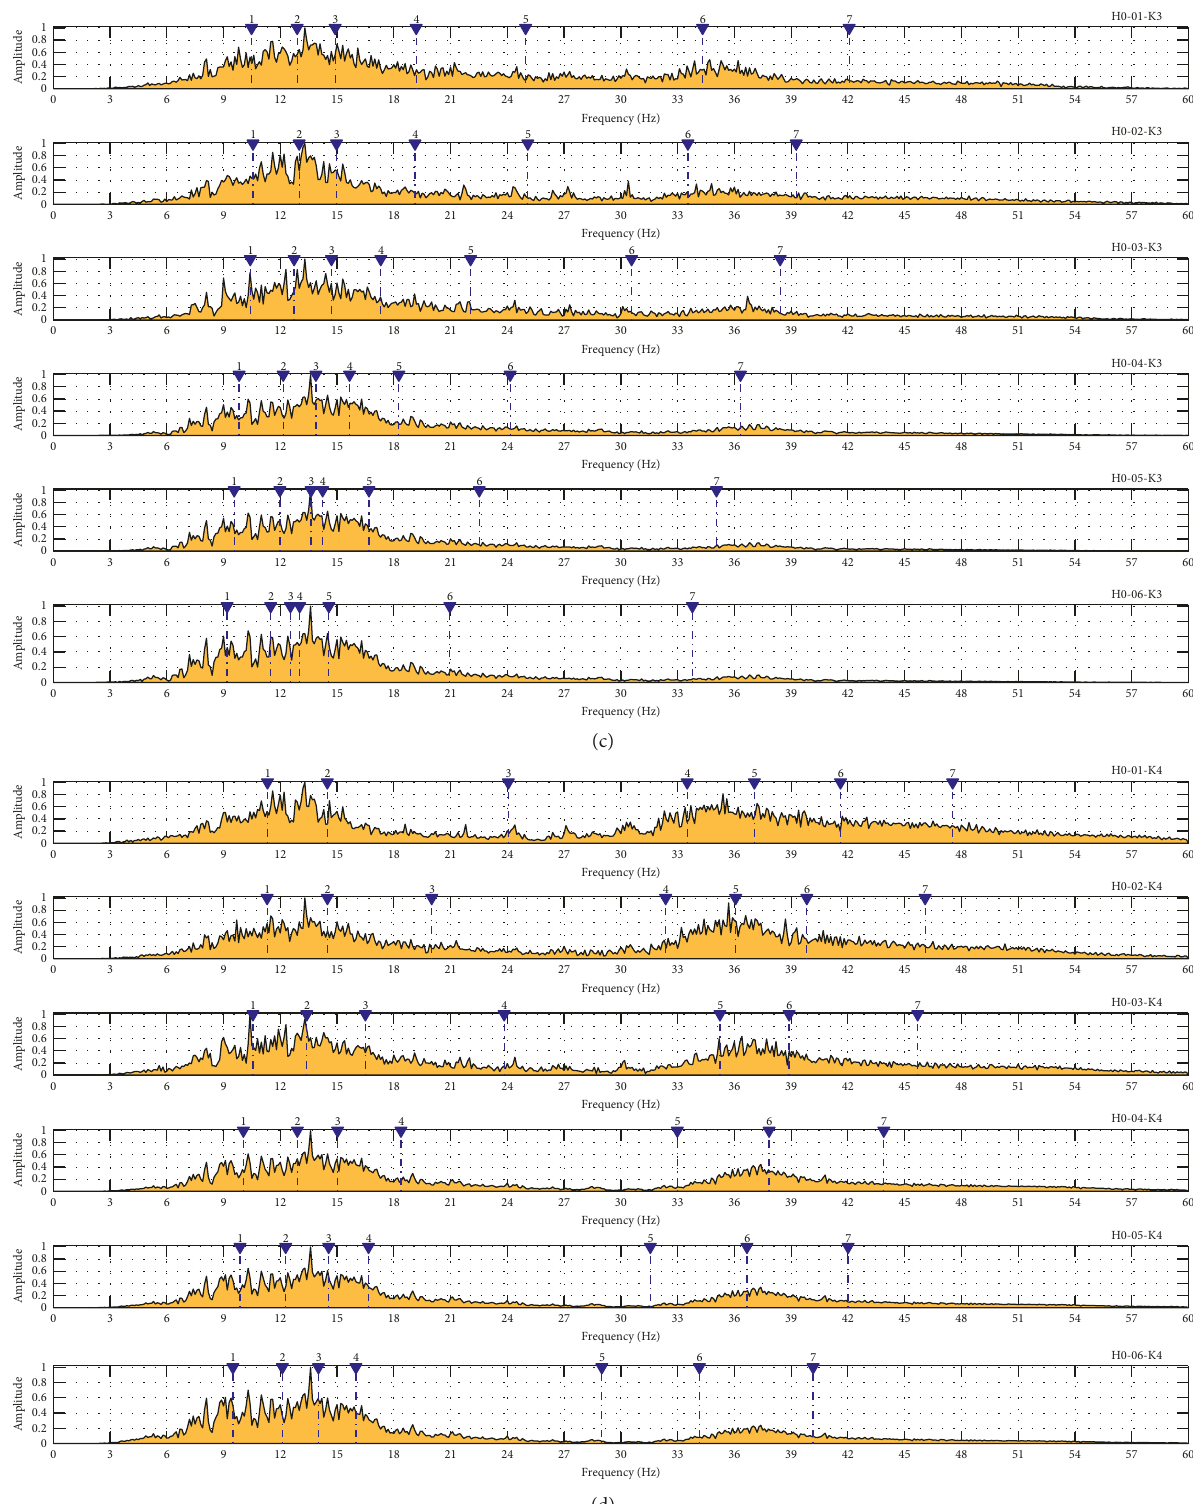
Figure 18: The change of the central position of the spectrum through 4 measurement channels of 6 different fatigue